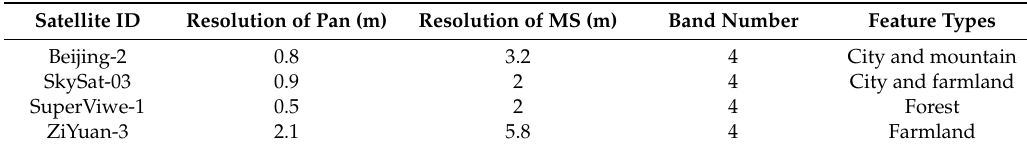
Table 1. Conditions of experimental data. ID—identifier; Pan—panchromatic; MS—multi-spectral.